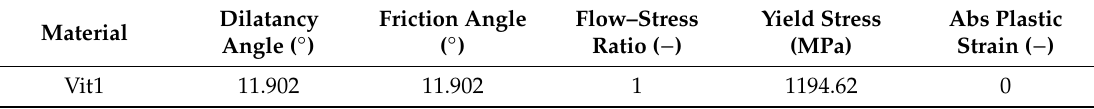
Table 3. Related parameters of linear D–P model of BMG.